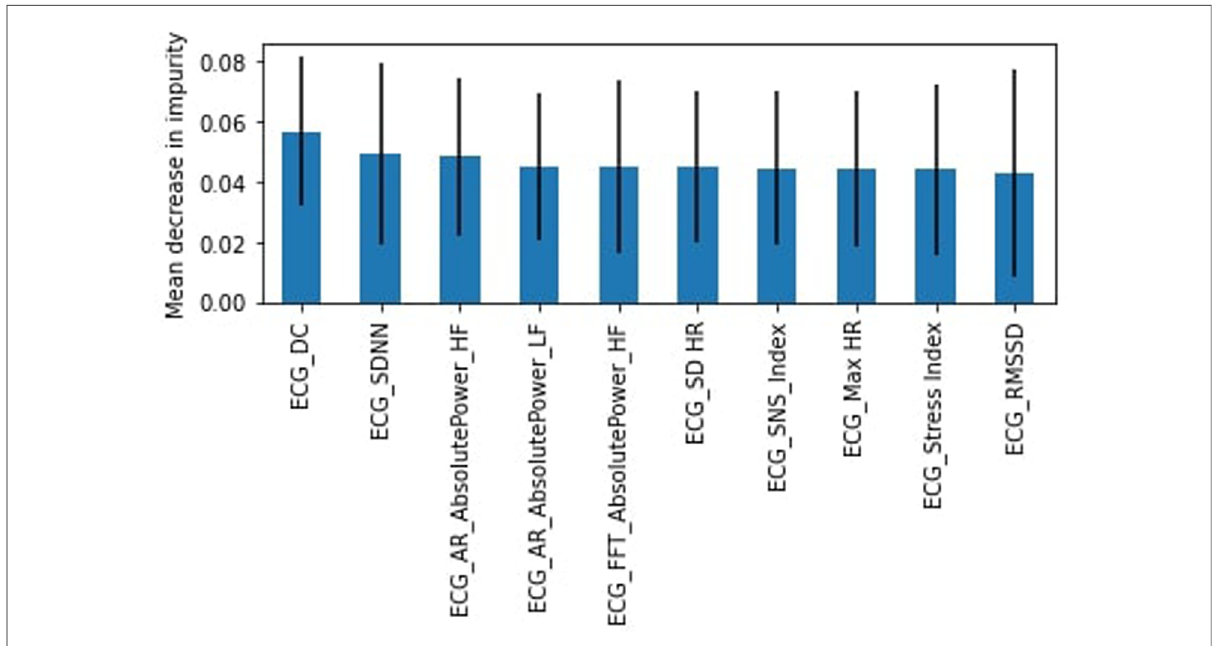
FIGURE 3 RF feature importance, complete